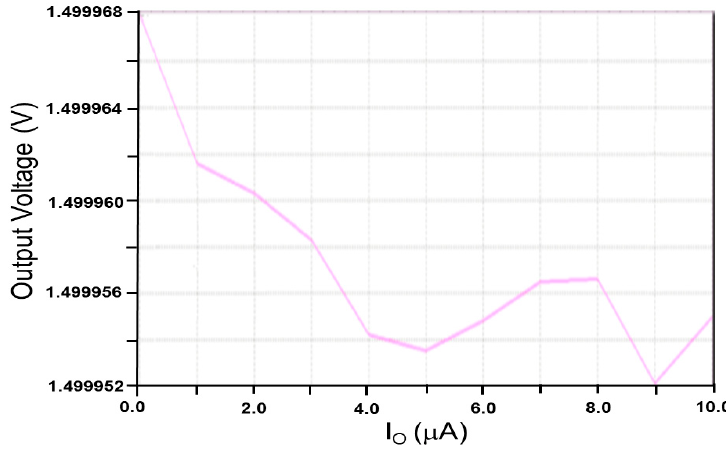
Figure 12. Simulated line regulation of the proposed LDO regulator.